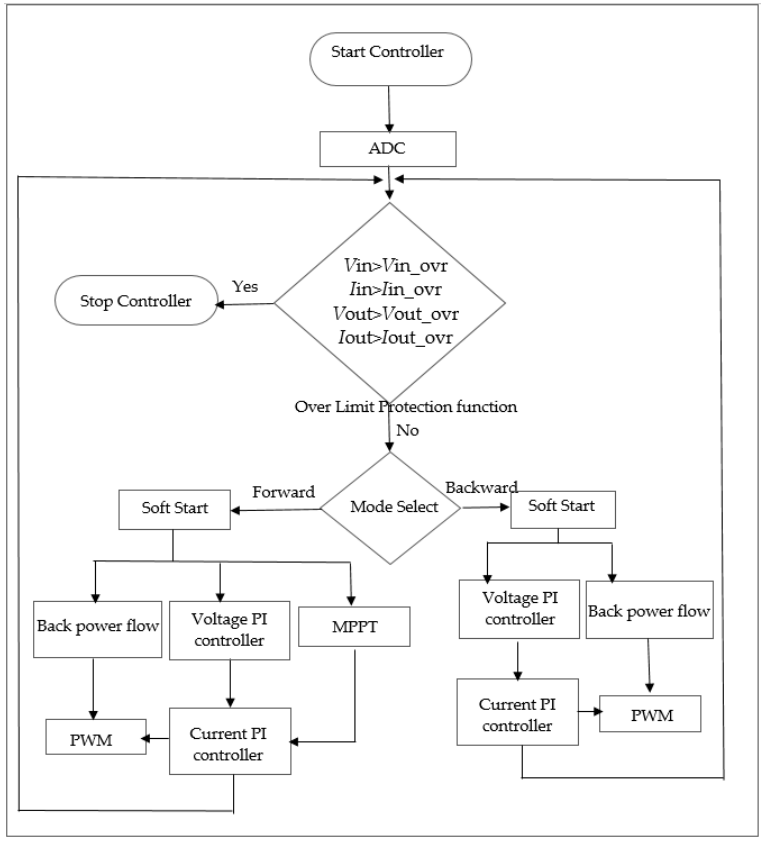
Figure 8. Blended SPS-ESPS digital control algorithm flow chart.